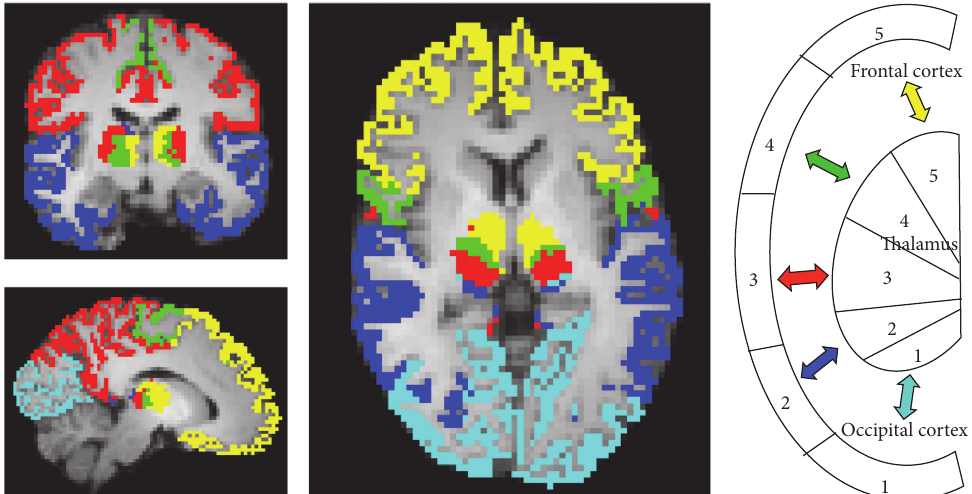
Figure 1: Find-the-biggest segmentation of the thalamus into five clusters and their corresponding cortical target masks in a NS subject ( 𝑥 = 52 , 𝑦 = 48 , 𝑧 = 28 ). Occipital cluster 1 (light blue), temporal cluster 2 (dark blue), somatosensory postcentral cluster 3 (red), motor precentral cluster 4 (green), and frontal cluster 5 (yellow). The right part of the figure shows a color-coded schematic illustration of the thalamocortical